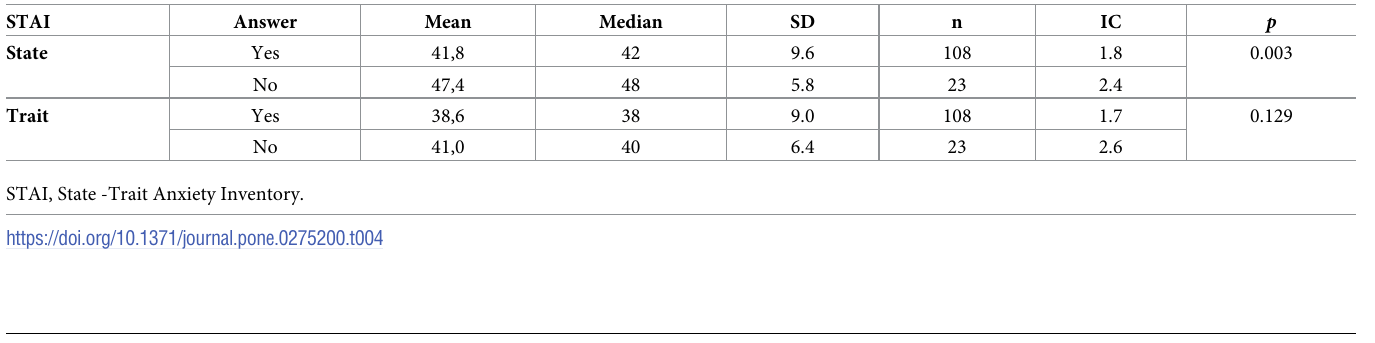
STAI, State -Trait Anxiety Inventory.